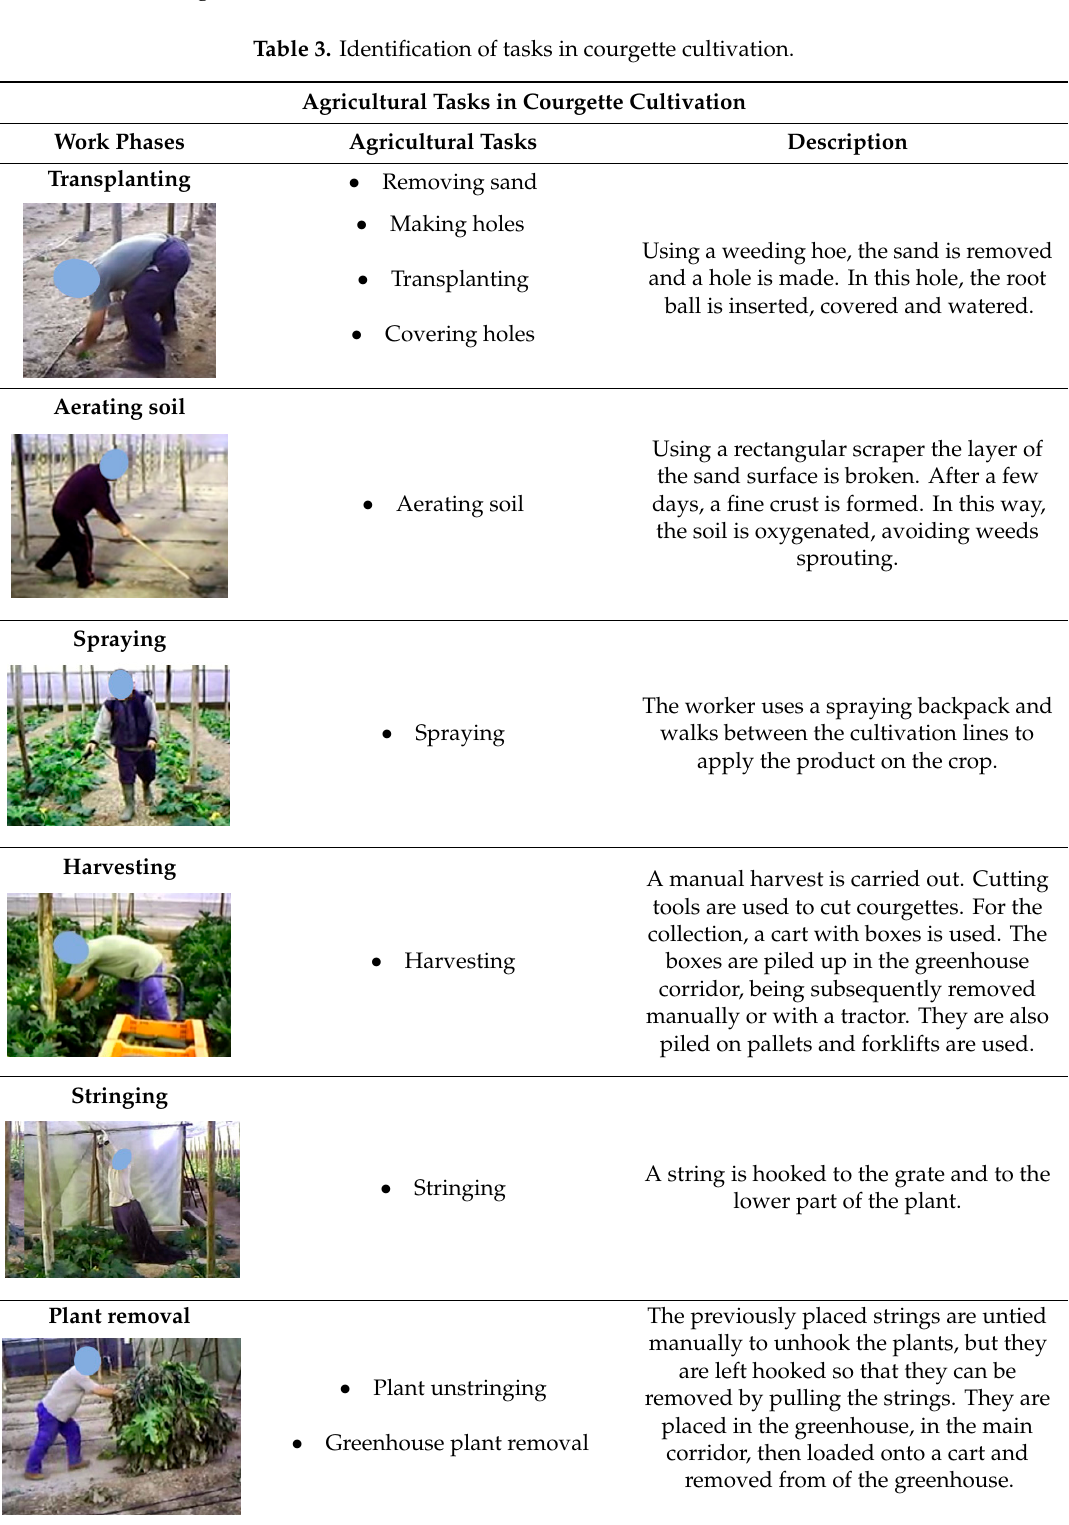
Table 3. Identification of tasks in courgette cultivation.